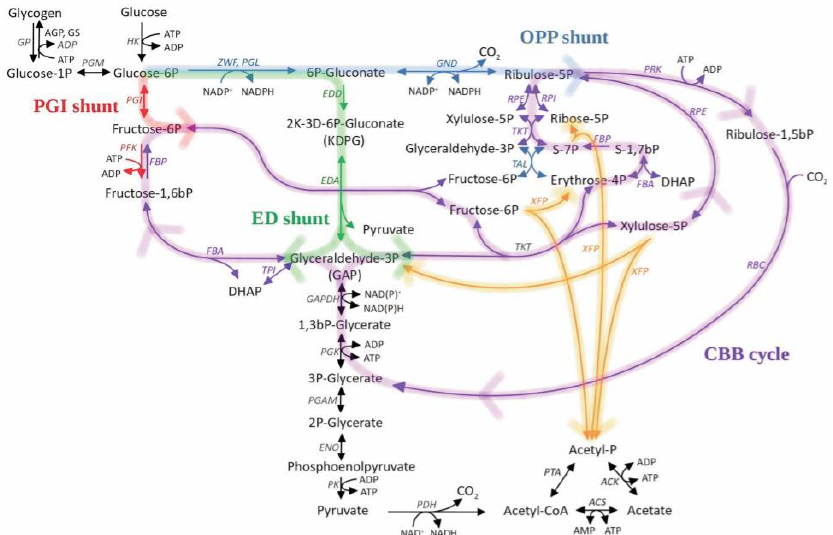
Figure 1. Relationship between the Calvin-Benson-Bassham (CBB) Cycle and Glycolytic Pathways in cyanobacteria. Abbreviations: acetate kinase (ACK), acetyl-CoA synthetase (ACS), glucose-1-phosphatase (AGP), KHG/KDPG aldolase (EDA), phosphogluconate dehydratase (EDD), enolase (ENO), fructose-bisphosphate aldolase (FBA), fructose bisphosphatase (FBP), glyceraldehyde